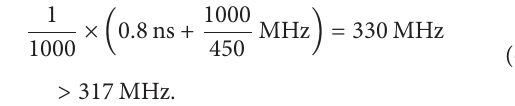
produces the lowest resulting frequency. Therefore, 0.5 ns